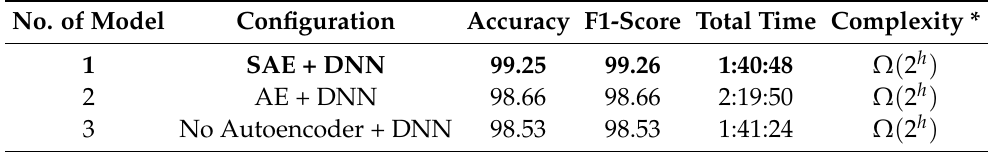
Table 12. Performance metrics for the cloneid _100 n node data